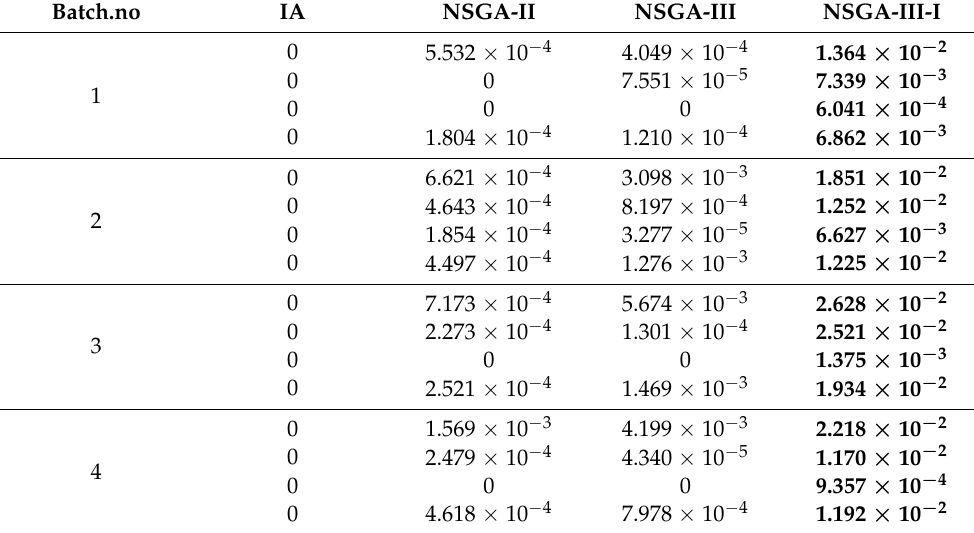
Table A4. Performance comparison between the proposed algorithm and other algorithms on the experimental problem with a batch size of